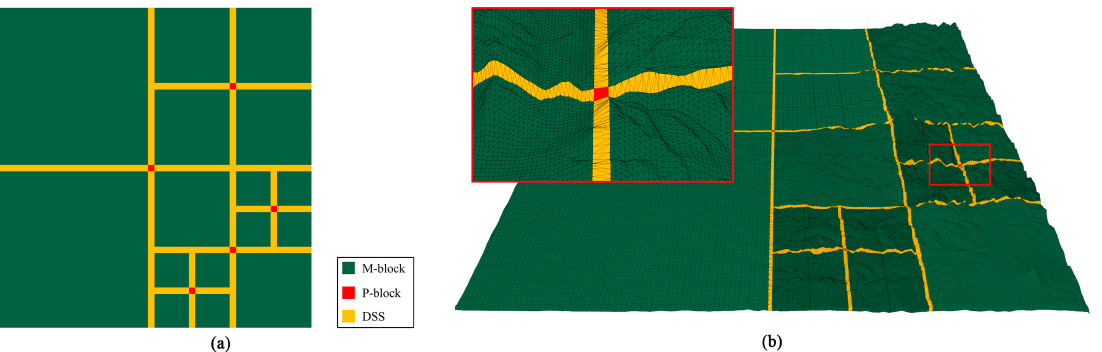
Figure 4. Three types of areas in the terrain model: ( a ) A 2D projection of the model. ( b ) The 3D model with wireframe overlay which has the same division with ( a ).